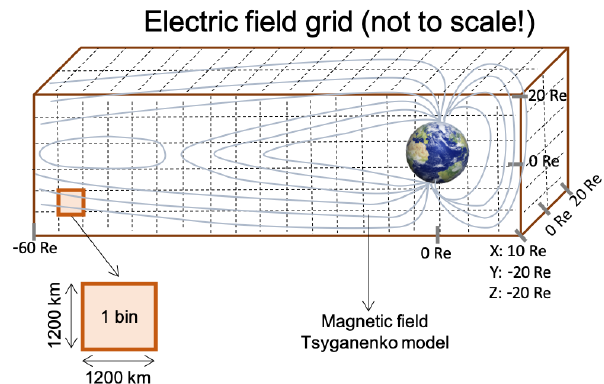
Figure 1. Schematic representation of the modelling of the Earth’s environment. The Earth’s magnetosphere is represented in light grey and the brown grid displays the electric field grid. Note that the illustration is not to